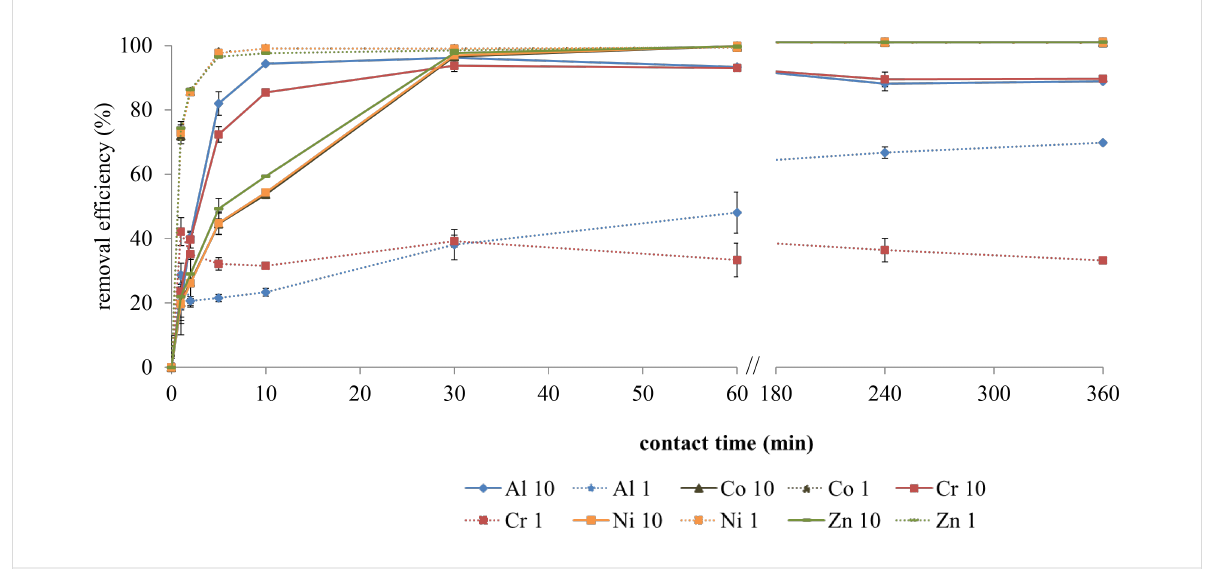
Figure 6: Adsorption kinetics for two solutions containing five metals at two concentrations (solution at 10 mg·L − 1 : full lines; solution at 1 mg·L − 1 : dashed lines) expressed as removal efficiency in % ( n = 3).